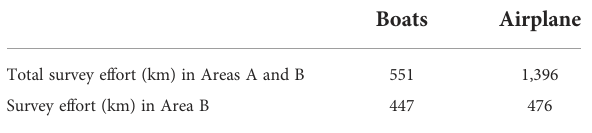
TABLE 1 Survey effort conducted by boats and airplane to estimate density of franciscana dolphins in Babitonga Bay, southern Brazil, in February